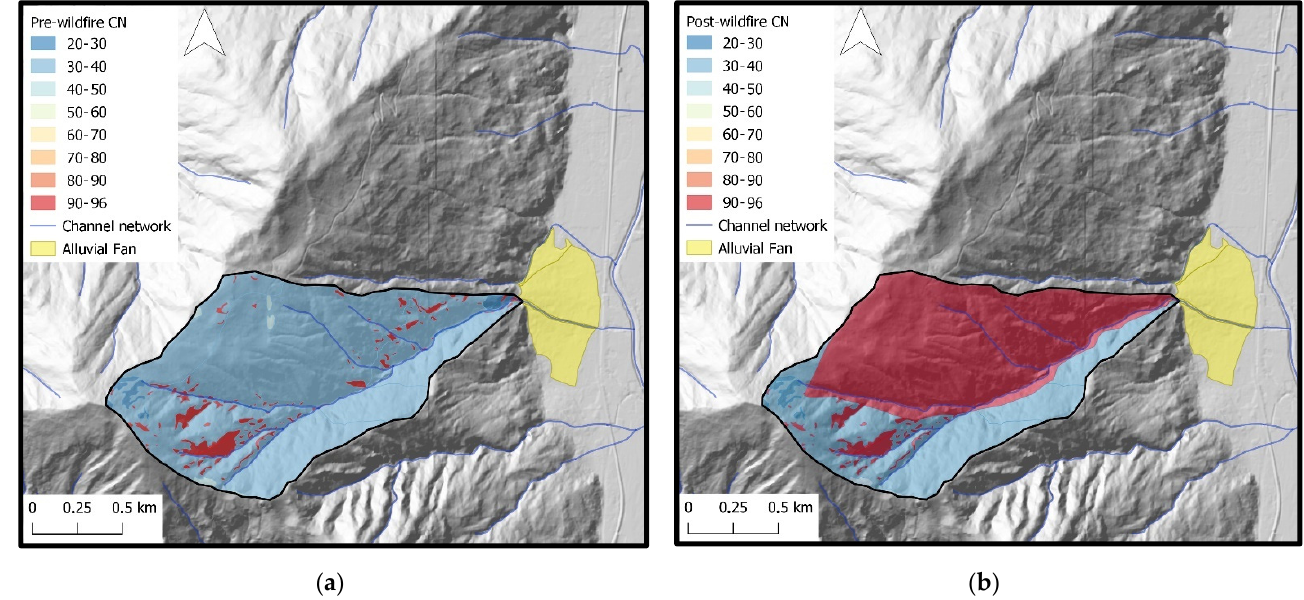
Figure 12. ( a ) Calculated CN for the Rio Casella catchment before the wildfire; ( b ) calculated CN for the Rio Casella catchment after the wildfire.